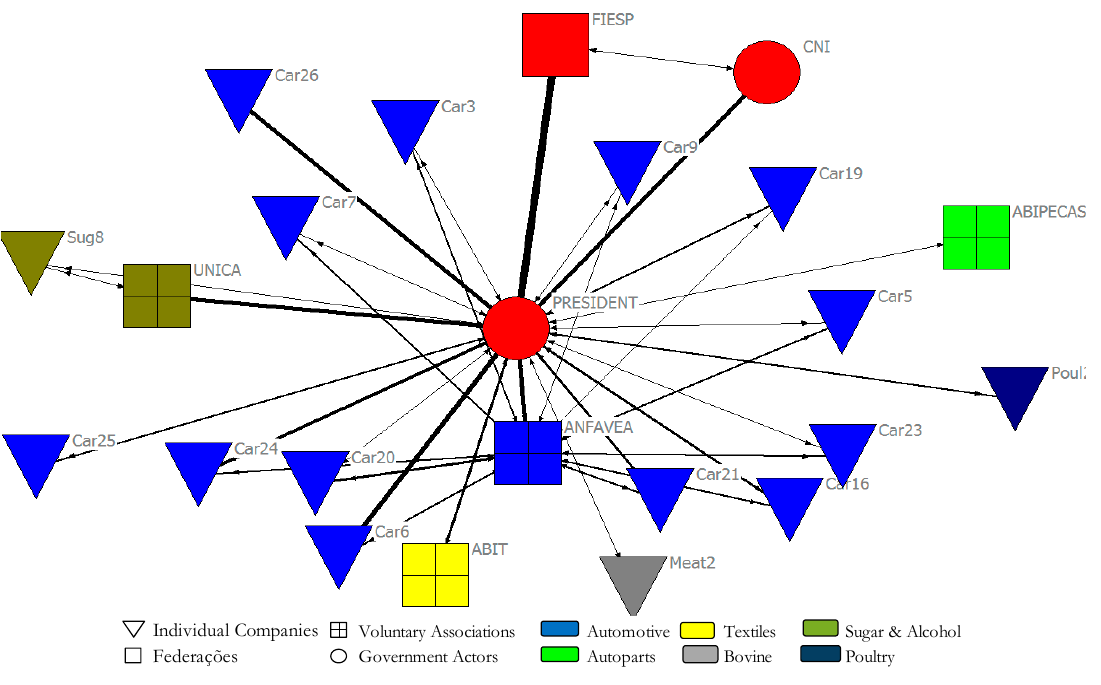
Figure 7. President’s direct ties (geodesic distance = 1).